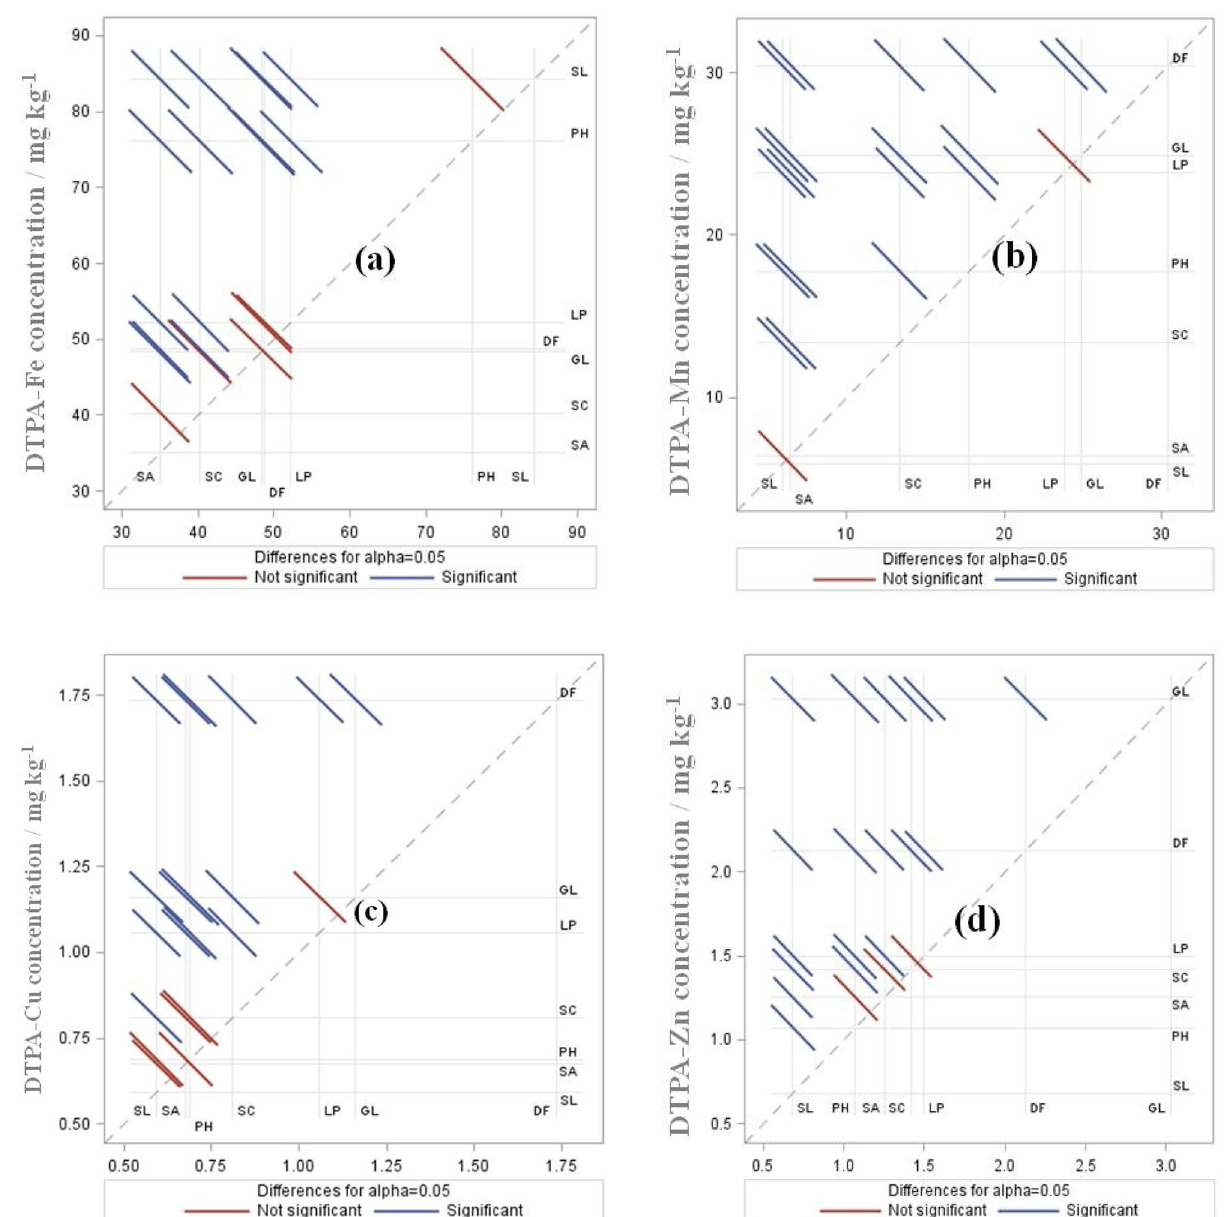
Figure 2. Diffograms showing significant differences among the seven land uses in available Fe, Mn, Cu and Zn contents. Bold horizontal and vertical lines represent the seven land uses of North-east India. The small lines passing through the squares diagonally represent non-significant or significant differences between the two corresponding land uses. Treatment abbreviations are SC shifting cultivation, SA settled agriculture, LP lowland paddy, EF evergreen forest, GL grassland, SL scrubland, and PH plantation and